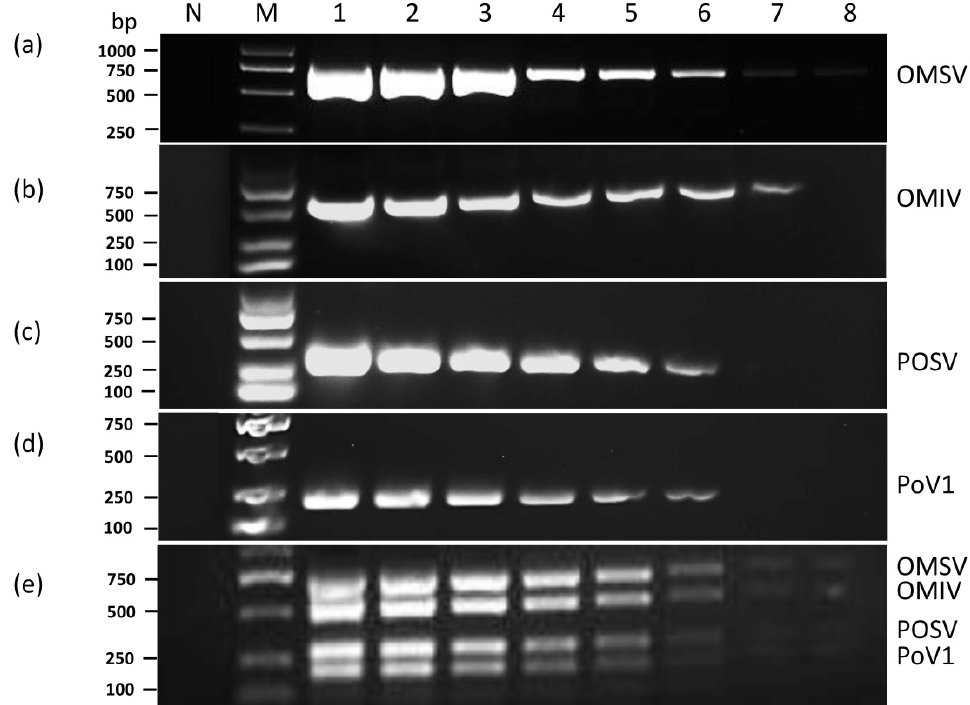
Figure 2. Detection limit based on ten-fold serial plasmid DNA dilutions of uniplex PCR and multiplex PCR detection. Uniplex PCR for ( a ) OMSV; ( b ) OMIV; ( c ) POSV; and ( d ) PoV1; ( e ) multiplex PCR. Lanes 1–8, 10 ng, 1 ng, 10 2 pg, 10 pg, 1 pg, 10 2 fg, 10 fg, and 1 fg of plasmids. N, negative control, the healthy P. ostreatus sample. Lane M: GL DNA Marker2000. The amplified gene sizes were 672, 540, 310, and 200 bp for OMSV, OMIV, POSV, and PoV1, respectively.